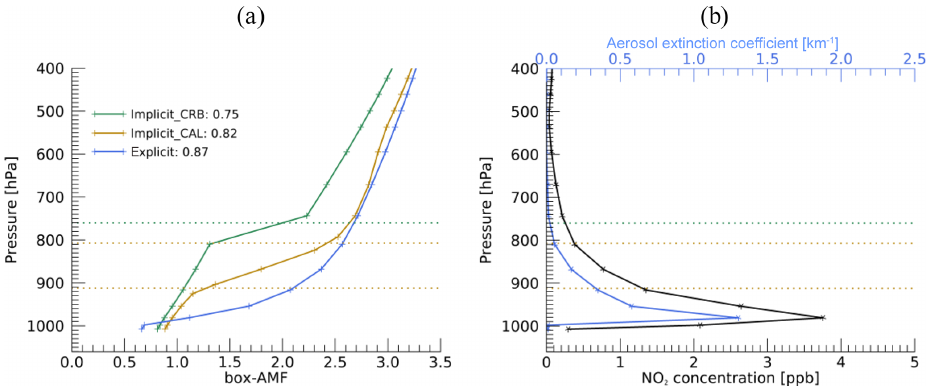
Figure 16. The NO 2 box-AMFs from the explicit aerosol correction and the implicit correction using the ROCINN_CRB and ROCINN_CAL cloud models (a) , and the TM5-MP NO 2 profiles and the MAXDOAS aerosol extinction profiles utilised in the retrievals (b) at Xianghe station on 21 November 2013. The tropospheric AMF is given next to each label in the legend. The ROCINN_CRB cloud top pressure is shown as a green horizontal dotted line, and the ROCINN_CAL cloud top and base pressures are shown as brown horizontal dotted lines. The cloud radiance fraction is 0.28, the cloud optical depth is 4.96, the aerosol optical depth is 0.66, the SZA is 66 ◦ , the VZA is 17 ◦ , and the RAA is 133 ◦ .